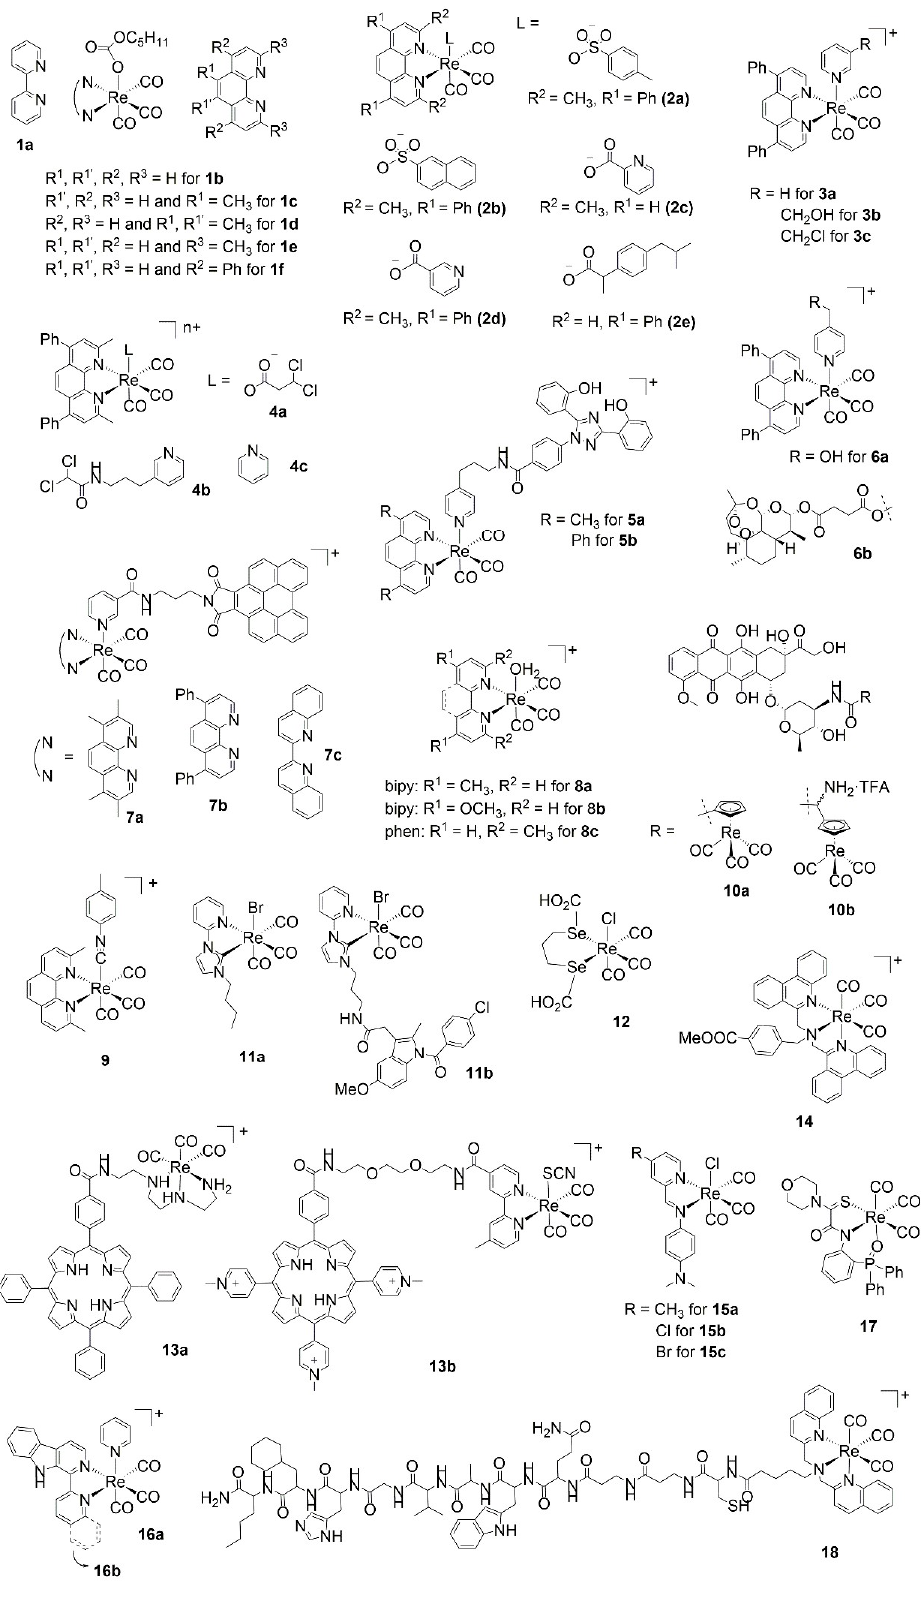
Figure 1. Selected structures of anticancer rhenium tricarbonyl complexes.